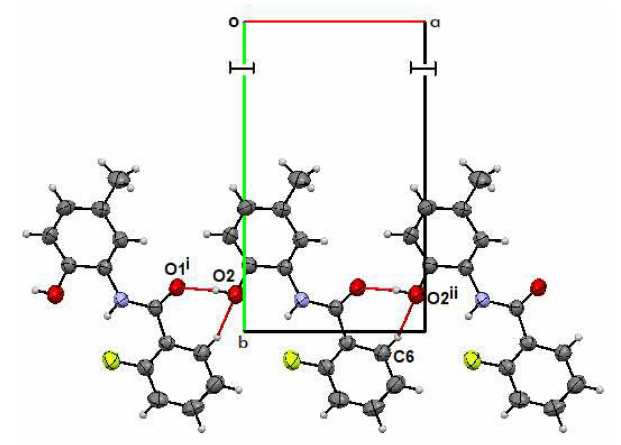
Figure 2. Crystal packing of o -FPhB seen along